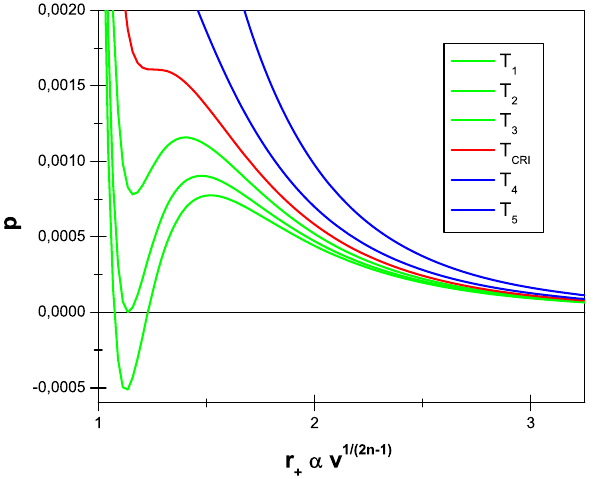
Fig. 2 p − v curve for T 1 < T 2 < T 3 < T c < T 4 < T 5